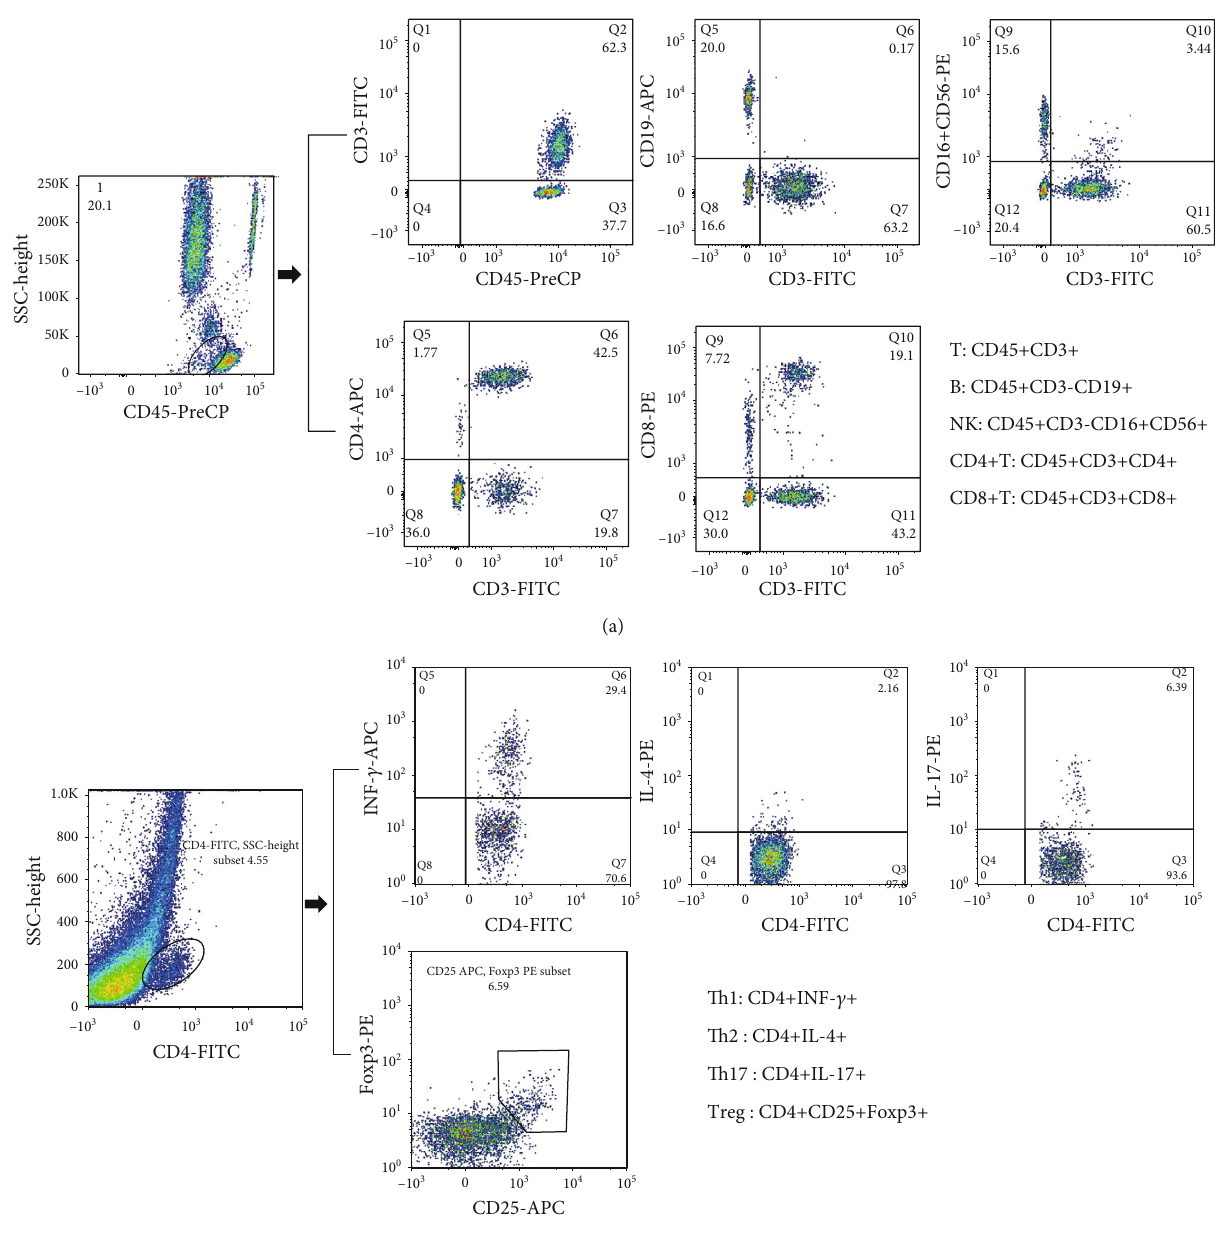
Figure 1: Phenotypic characterization of lymphocyte subpopulations by fl ow cytometry. (a) Representative fl ow cytometry analysis of peripheral lymphocytes. T: CD45+ CD3+; B: CD45+ CD3- CD19+; NK: CD45+ CD3- CD16+ CD56+; CD4+ T: CD45+ CD3+ CD4+; CD8+ T: CD45+ CD3+ CD8+. (b) Representative fl ow cytometry analysis of CD4+ T cell subsets. All dot plot analysis is of CD4+ gated lymphocyte. Th1:CD4+ INF- γ +; Th2: CD4+ IL-4+; Th17: CD4+ IL-17+; Treg: CD4+ CD25+